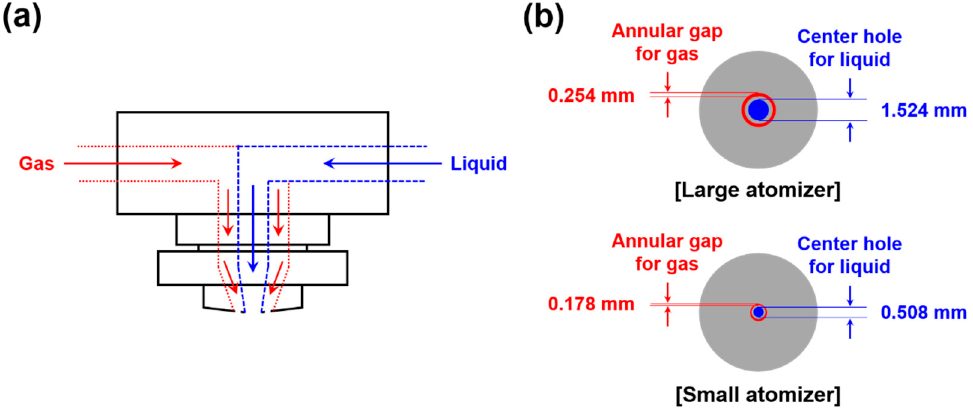
Figure 2. Schematic diagrams of twin-fluid atomizers: ( a ) side view and ( b ) bottom view.